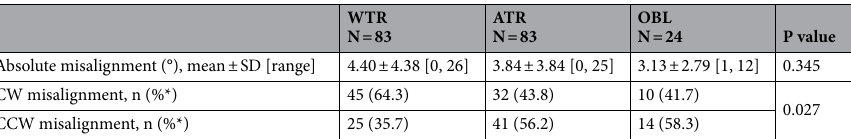
Table 3. Influence of the astigmatism direction on the TIOL degree of deviation and its direction. TIOL toric intraocular lens, CW clockwise, CCW counterclockwise, WTR with-the-rule (60°–120°), ATR